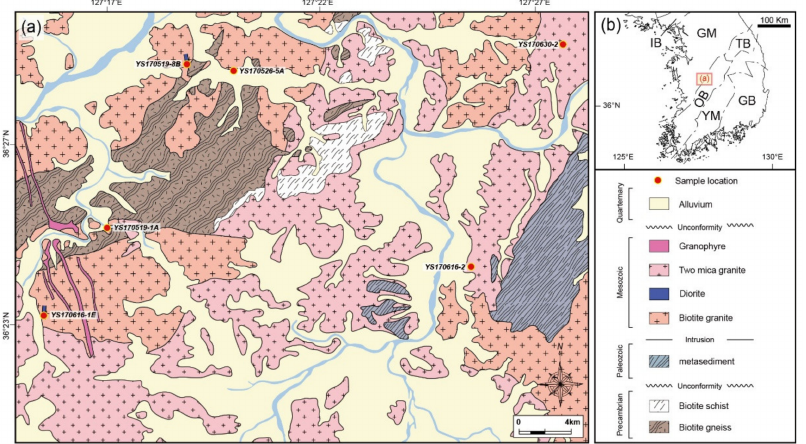
Figure 1. ( a ) Geological map of the Yuseong area (after, Park and Lee, [26]). ( b ) Simplified tectonic map of the southern Korean Peninsula. Abbreviations are as follows, GM: Gyeonggi Massif; YM: Yeongnam Massif; IB: Imjingang Belt; OB: Okcheon Belt; TB: Taebaeksan Basin; GB: Gyeongsang